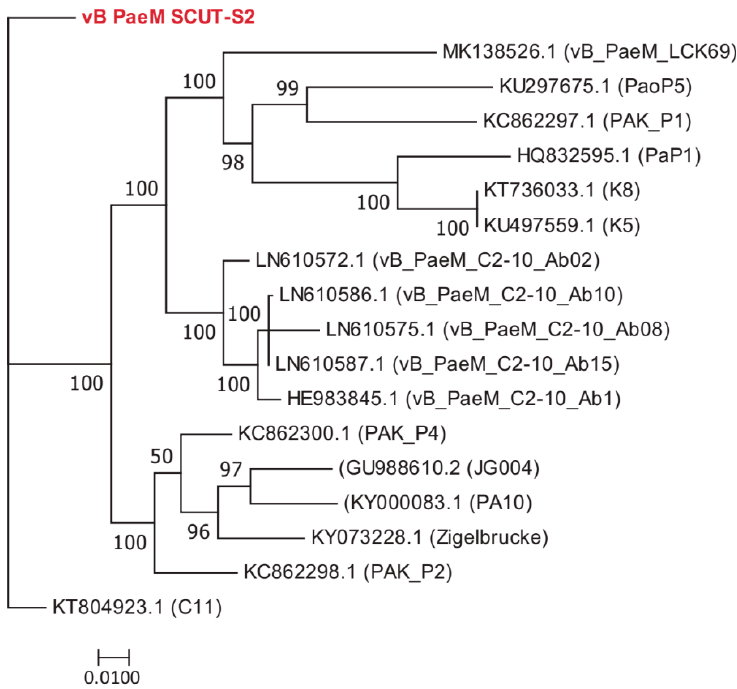
Figure 5. Maximum likelihood tree showing the phylogenetic relationships among phages of genus Pakpunavirus . The whole genome sequences were aligned by MAFFT [37] and the tree was visualized by MEGA 7 [40]. The value at the nodes indicated the bootstrap support scores as calculated using 1000 replicates. Phage vB_PaeM_SCUT-S2 was colored